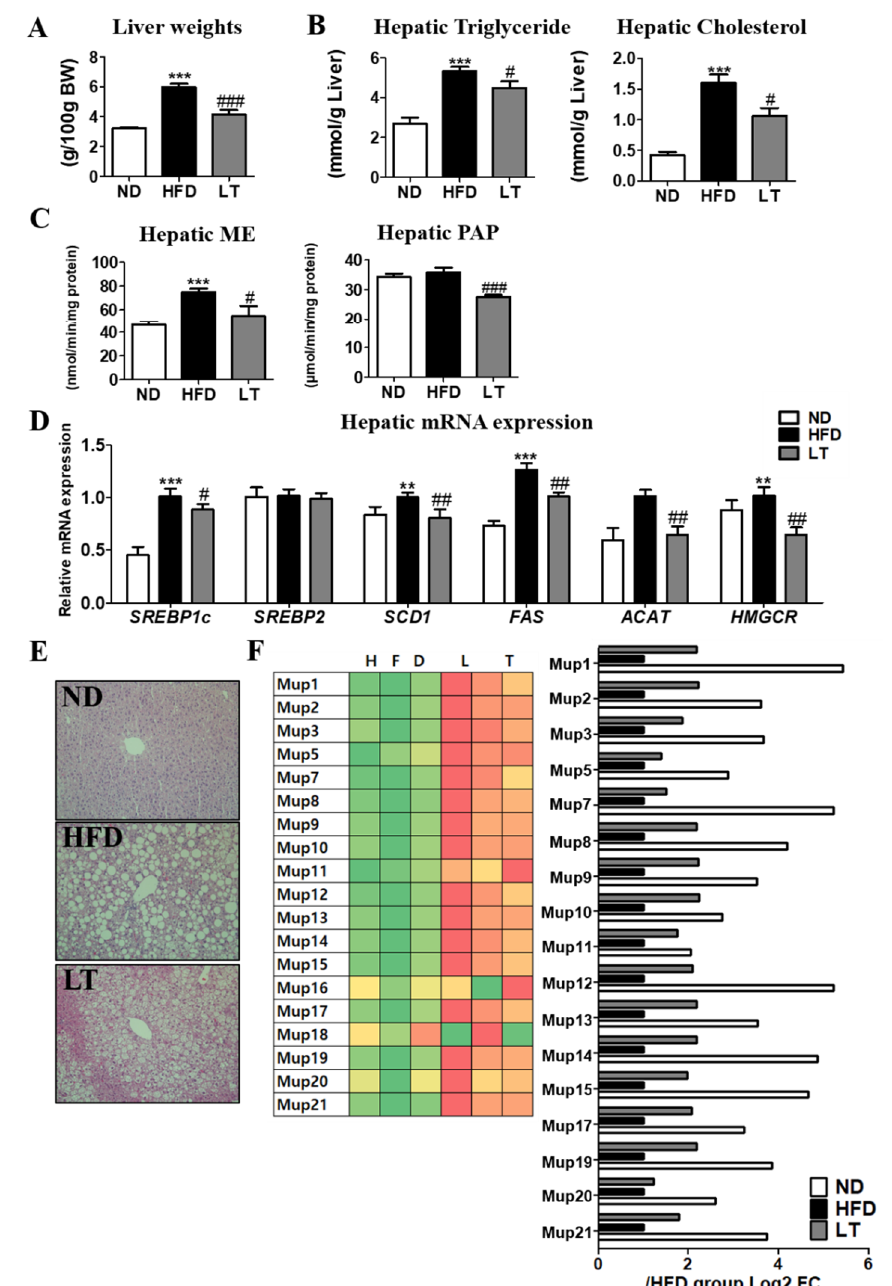
Figure 3. Effect of LT water extract supplement in diet-induced obesity on liver weight ( A ), hepatic lipid contents ( B ), hepatic lipid-regulating enzyme activities ( C ), hepatic mRNA expression ( D ), hepatic morphology (200 × magnification) ( E ) hepatic mRNA expression of MUPs using mRNA-sequencing ( F ); Data are the mean ± SE. Significant differences between HFD versus ND are indicated: ** p < 0.01, *** p < 0.001. Significant differences between HFD versus LT are indicated: # p < 0.05, ## p < 0.01, ### p < 0.001. ND, normal diet (AIN-93G); HFD, high-fat diet (60% kcal from fat); LT, HFD + Lycopus lucidus Turcz water extract (1.5%, w/w ); ME, malic enzyme; PAP, phosphatidic acid phosphatase; SREBP, sterol regulatory element binding proteins; SCD1, Stearoyl CoA Desaturase 1; FAS, fatty acid synthetase; ACAT, Acyl-CoA cholesterol acyltransferase; HMGCR, 3-hydroxy-3-methyl-glutaryl-coenzyme A reductase.